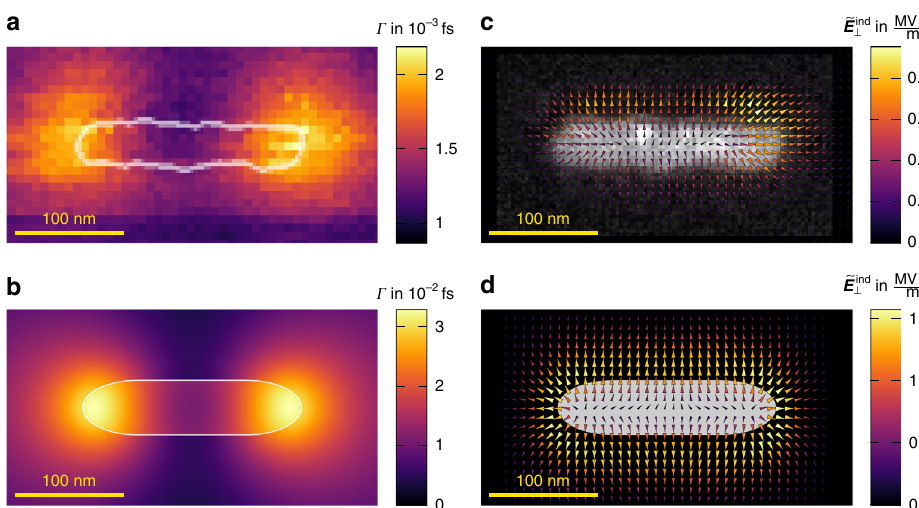
Fig. 3 Comparison of reconstructed and simulated quantities. Energy- fi ltered experimental ( a ) and simulated ( b ) energy loss probabilities (Eq. (2)) within the energy interval indicated in the spectra (Fig. 2b) and the experimental ( c ) and simulated ( d ) electrical fi eld maps (Eq. (4)) of the Al nanorod. The fi eld maps show the transient fi eld for the speci fi c energy loss (i.e. a spectral component) selected by the